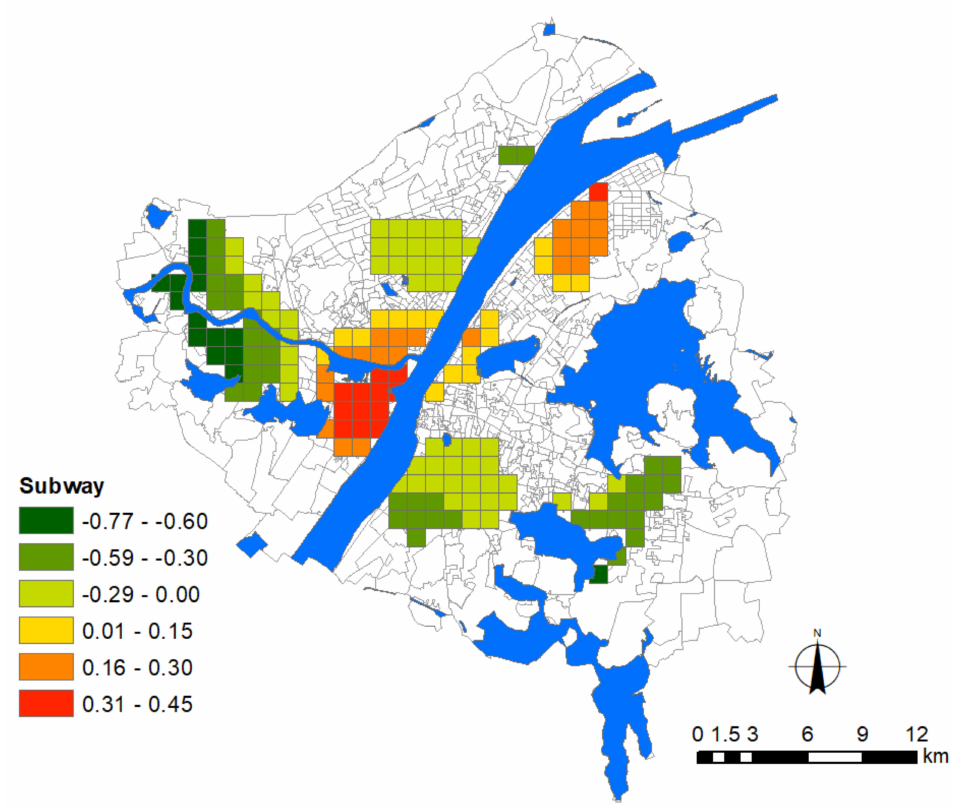
Figure 11. Areas significantly a ff ected by the subway station. The legend denotes the corresponding intensity of